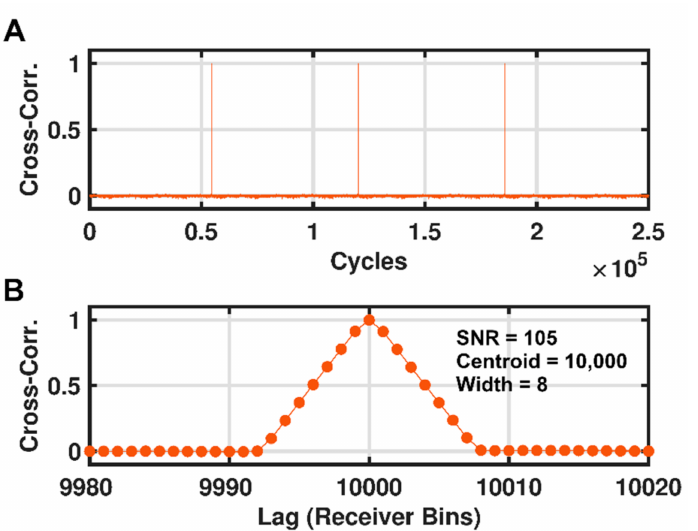
Figure 19. FPGA cross-correlation results of PN code and kernel. ( A ) Continuous output from the IFFT core of the SALi processing pipeline normalized to the peak value. The cycles correspond to clock cycles of the pipelined IFFT code. ( B ) Cross-correlation peak from ( A ) translated into lag between code and kernel (i.e., ambiguous range). The circles represent the discrete IFFT values from which the centroid, width, and SNR were